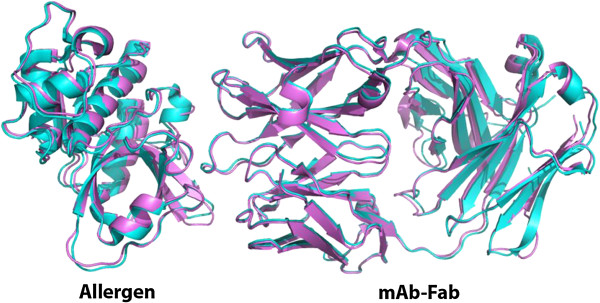
Overlap of the X-ray crystal structures of natural Der p 1 in complex with an Fab of the mAb 4C1 (cyan) with the X-ray crystal structure of Der f 1 in complex with the same antibody fragment (violet). The structures show the molecular basis of cross-reactivity between both dust mite allergens: the Fab recognizes the same area in Der p 1 and Der f 1, which is a conformational epitope overlapping with an IgE antibody binding site
[24].